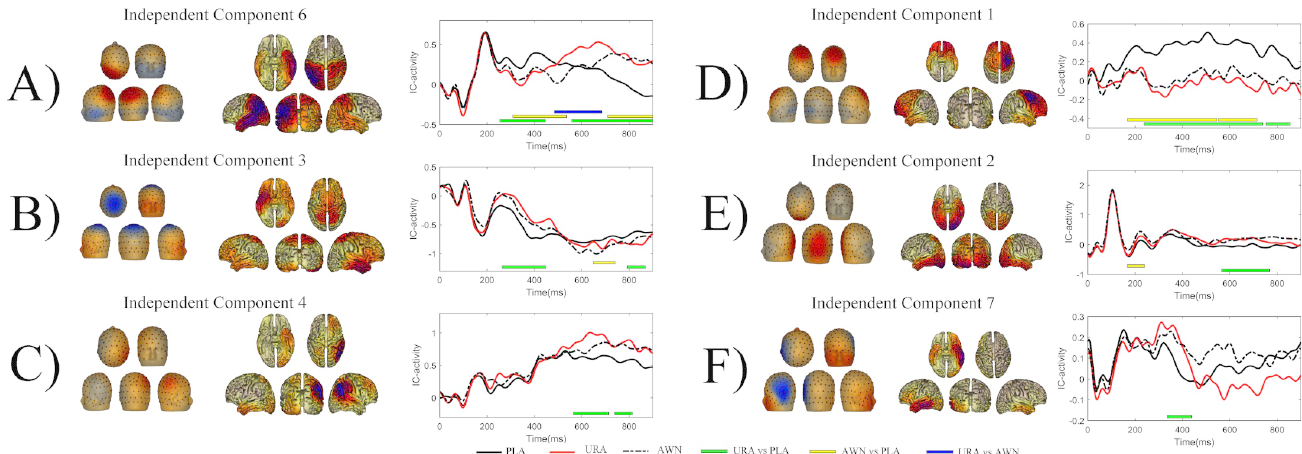
Fig 6. Condition effects in independent components. Topographies of the individual IC spatial filters are shown on the left side of the sub-figure. Red denotes a positive spatial filter weight and blue a negative spatial filter weight. Please note that depending on the activity of the component polarity on the scalp, the sensors change accordingly (for example, in sub-figure A, component 6 is contributing positive voltage to the scalp; however, roughly between 200ms to 500ms anomalous conditions have a more negative–or ‘less positive’–contribution to the measured scalp activity). Cortically restricted LORETA solutions of the individual components are presented in the middle. Temporal evolutions of the components in each condition are shown on the right side of picture (solid black line denoting plausible condition, solid red line unrelated anomalous condition and dashed black line indicating anomalous word neighbour condition); bars under the waveforms denote statistically significant clusters of observations after minimum duration correction (green: unrelated anomalous vs. plausible, yellow: anomalous word neighbour vs. plausible and blue: unrelated anomalous vs. anomalous word neighbour). Acronyms: PLA = Plausible, URA = Unrelated anomalous and AWN = Anomalous word neighbour.